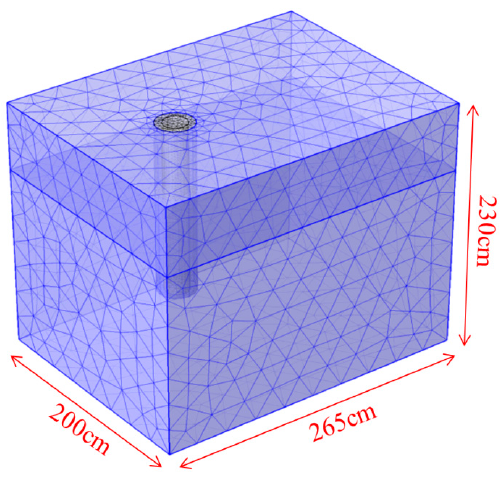
Figure 6. Numerical model of soil and pile.